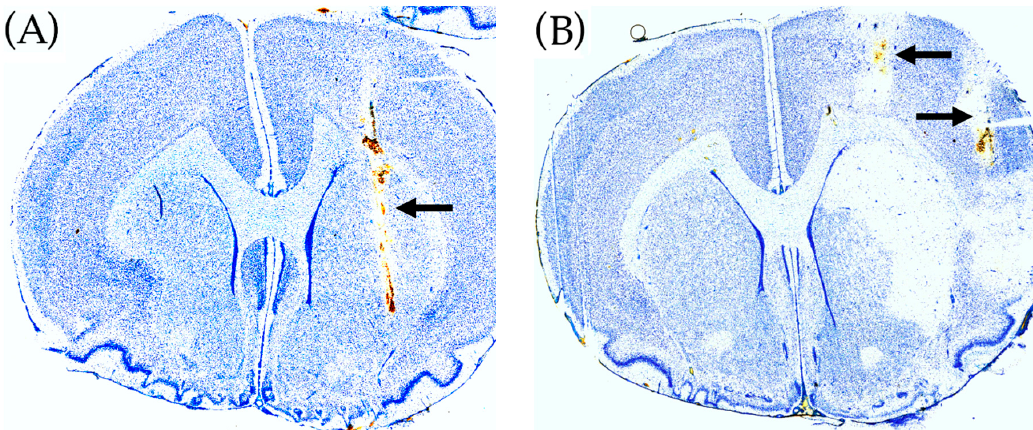
Figure 4. Histology of rat brains using toluidine blue staining. ( A ) Malonate perfusion model. The position of the microdialysis probe in striatum is shown by the arrow. ( B ) ET-1 rat model of transient cerebral ischemia. The position of the guide cannula for the microdialysis probe in the ipsilateral striatum is shown by the upper arrow (the microdialysis probe track in striatum is not visible). The position of the guide cannula for ET-1 infusion in the pirifom cortex is shown by the lower arrow. ET-1 infusion caused histological damage in the ipsilateral striatum.